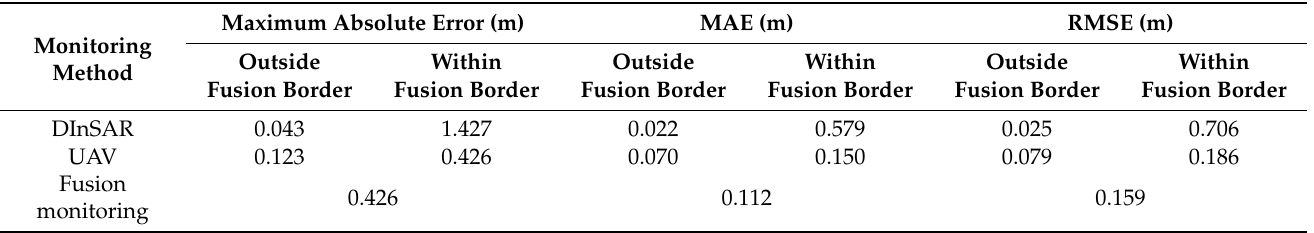
Table 2. Accuracy comparison between the single means and fusion monitoring along line A.